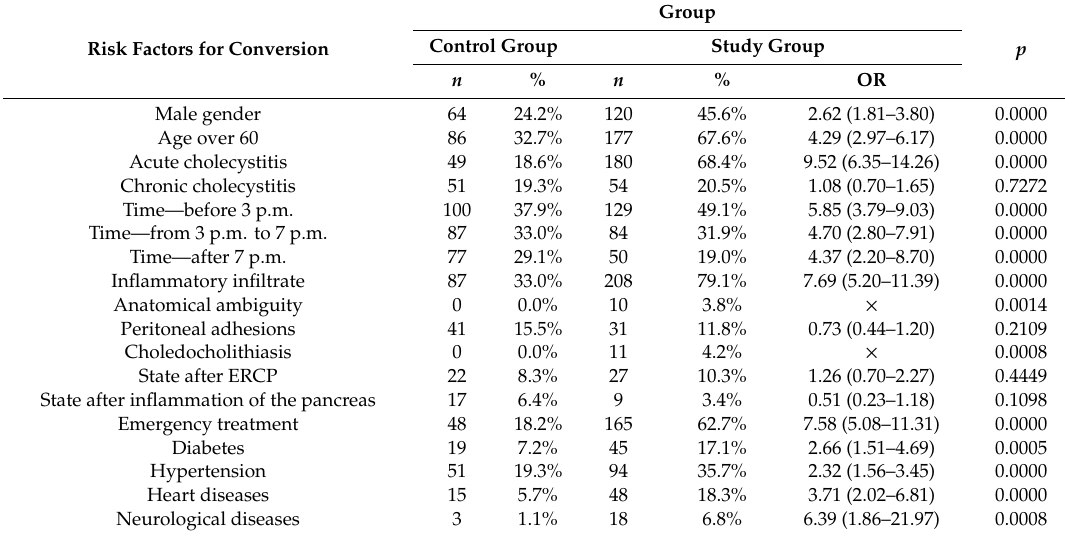
Table 3. Odds ratio values for the risk